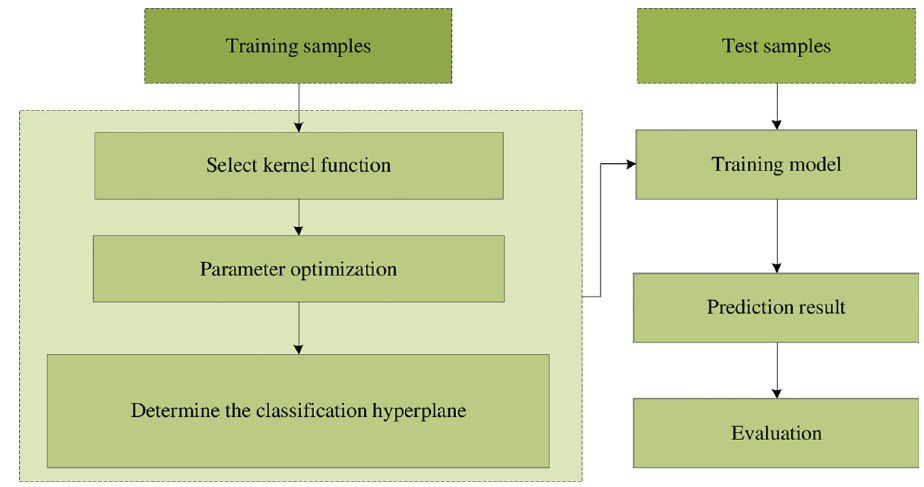
Fig 9. The calculated process of the SVM model.